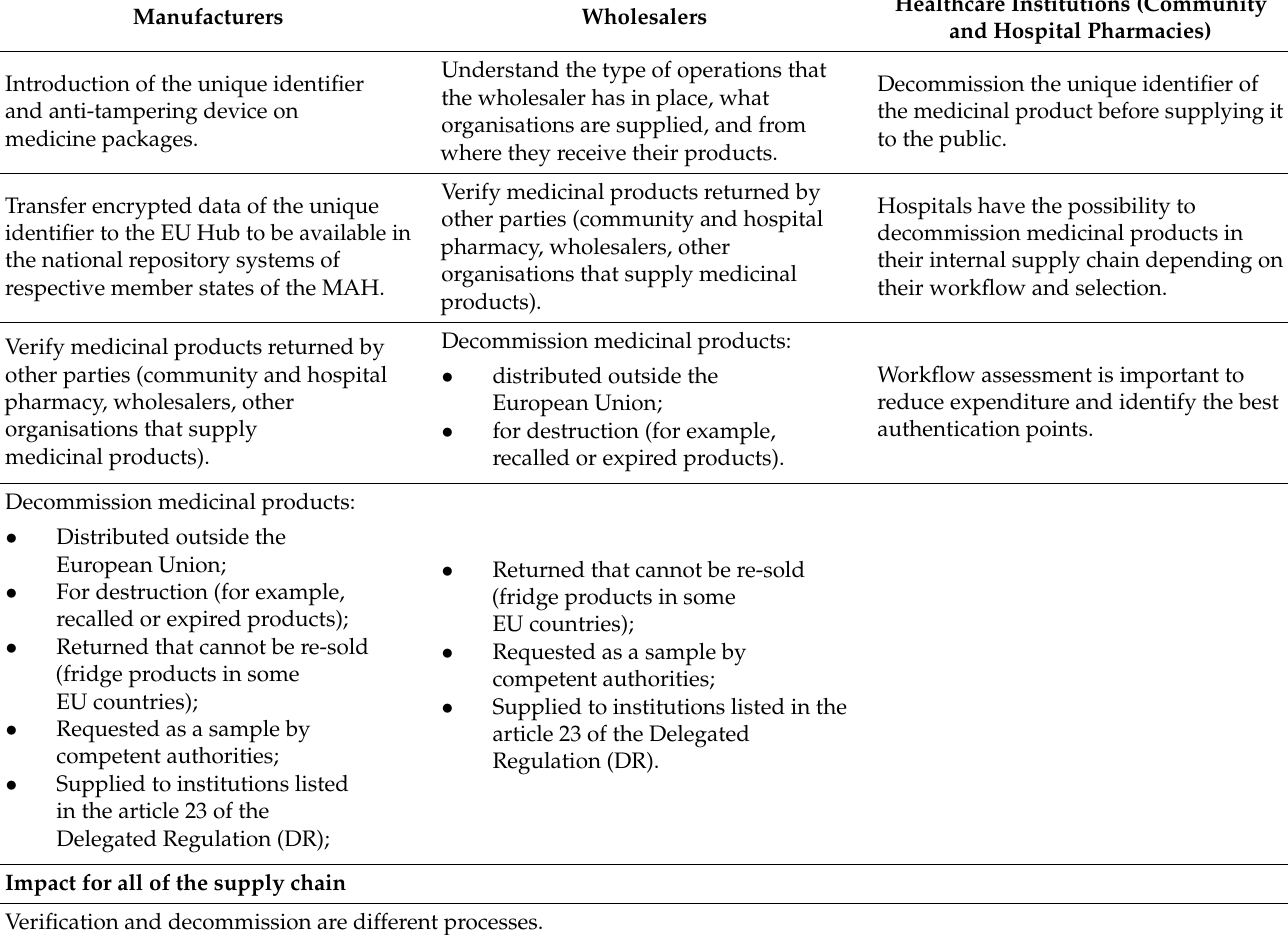
Table 1. Summary of the impact of the FMD in the pharmaceutical supply